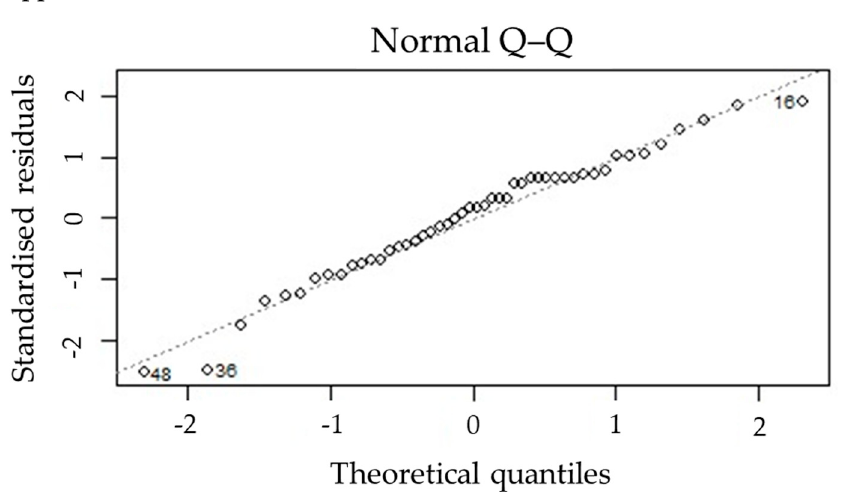
Figure A1. Quantile–quantile (Q–Q) plot of the residuals for the temperature-induced dose component model. The straight-line clustering suggests a normal distribution of the residuals of the fitted polynomial function.